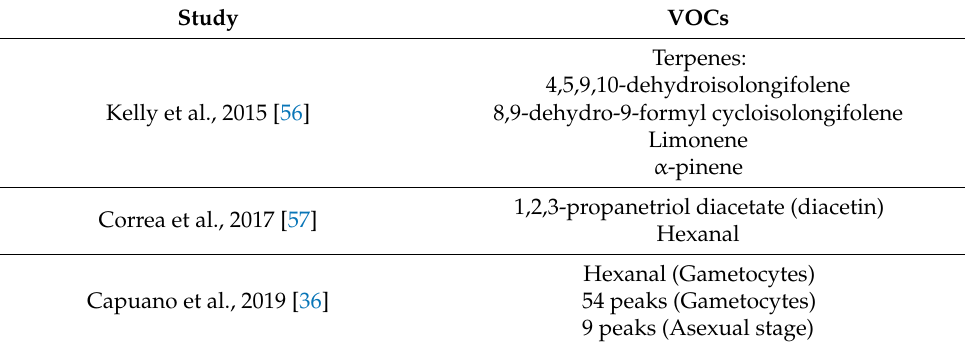
Table 3. VOCs emitted by in vitro cultures of Plasmodium parasites.